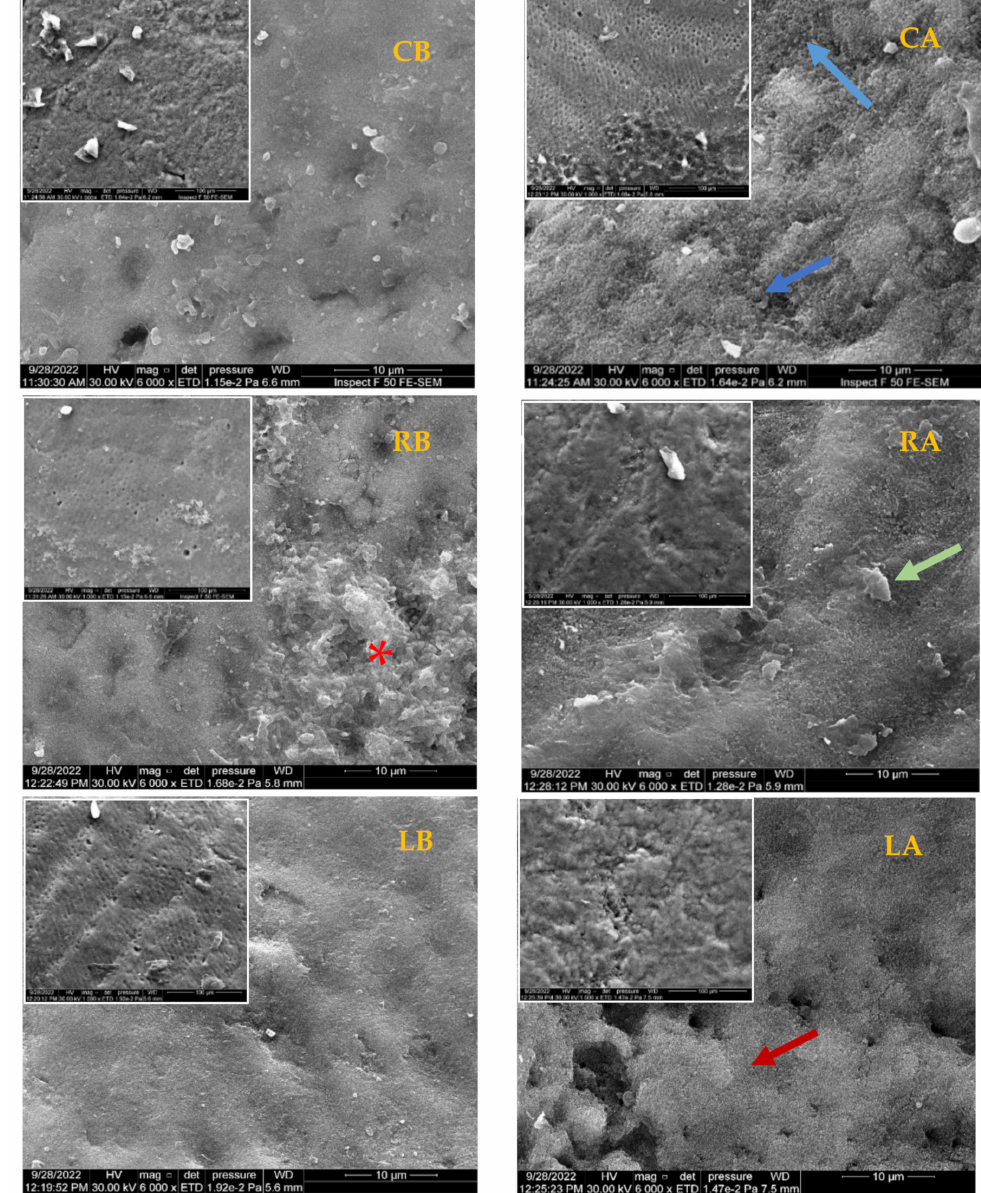
Figure 5. Scanning electron micrograph of representative specimens of control group before and after pH-cycling (CB, CA), Regenerate-treated group (RB, RA), and CO 2 laser-treated group (LB, LA). The destructive effect of acid challenge is clearly visible in the control group (CA, the blue arrows). The enamel surface that treated by Regenerate appears to be well-covered and protected after acid challenge (RA, the green arrow) with presence of mineral-like deposit at the surface before pH- cycling (RB, red asterisks). In the laser-treated group, the changes in enamel surface (the melting effect) is noted before and after pH-cycling which might make the surface more resistant to the acid attack in comparison to control (LA, the red